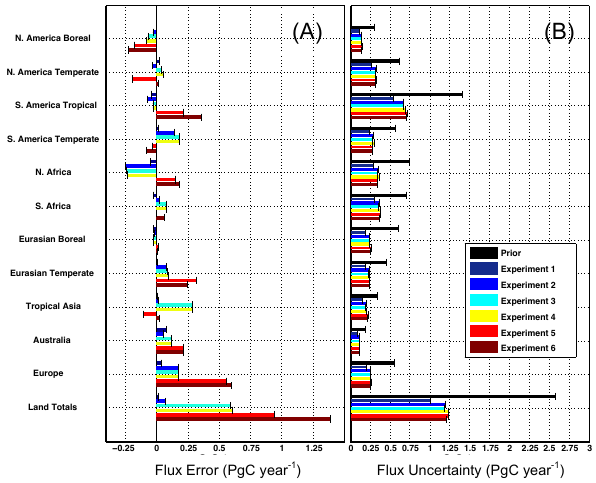
Fig. 6. Flux errors during boreal summer (June-July-August) in (A) Experiment 1 and (B) Experiment